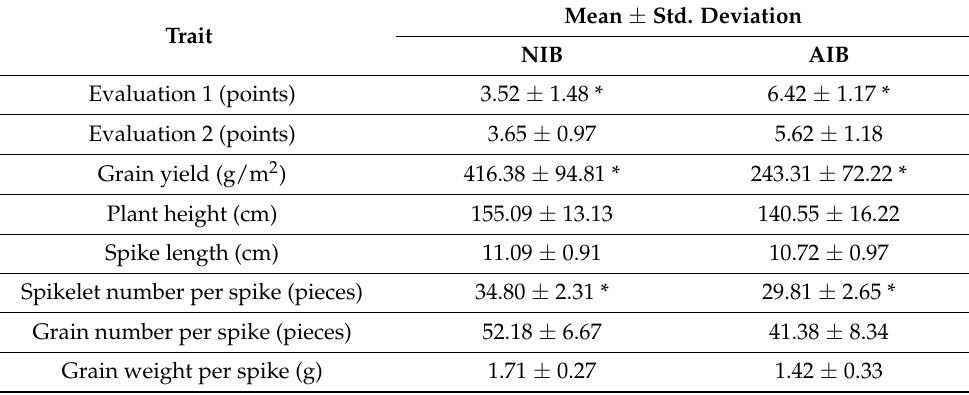
Table 2. Mean ± standard deviation of disease scores determined at evaluation 1 (snow mold damage within a week after the snow melt), evaluation 2 (the plant regrowth ability two weeks after the evaluation 1), grain yield, and parameters of yield structure, for 58 rye samples, under a natural infection background (NIB) and an artificially-enriched infection background (AIB) in 2021. * Statistically significant at p ≤ 0.05 ( t